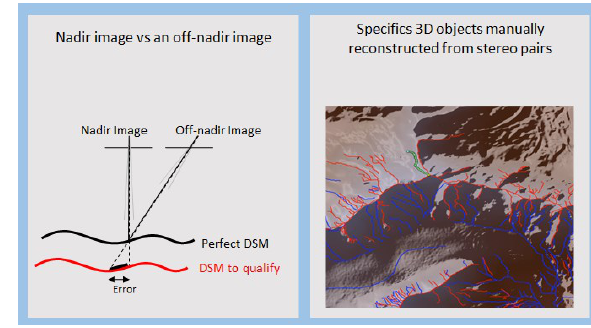
Figure 14. Examples of DSM Quality Control